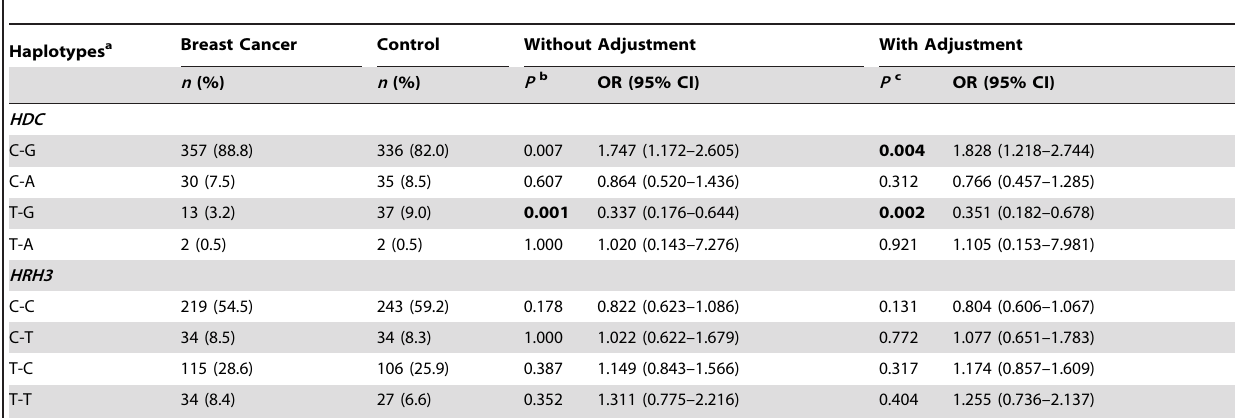
Table 4. Associations between risk of breast cancer and haplotypes of two HDC variants (rs7164386 and rs7182203) and two HRH3 variants (rs3787429 and